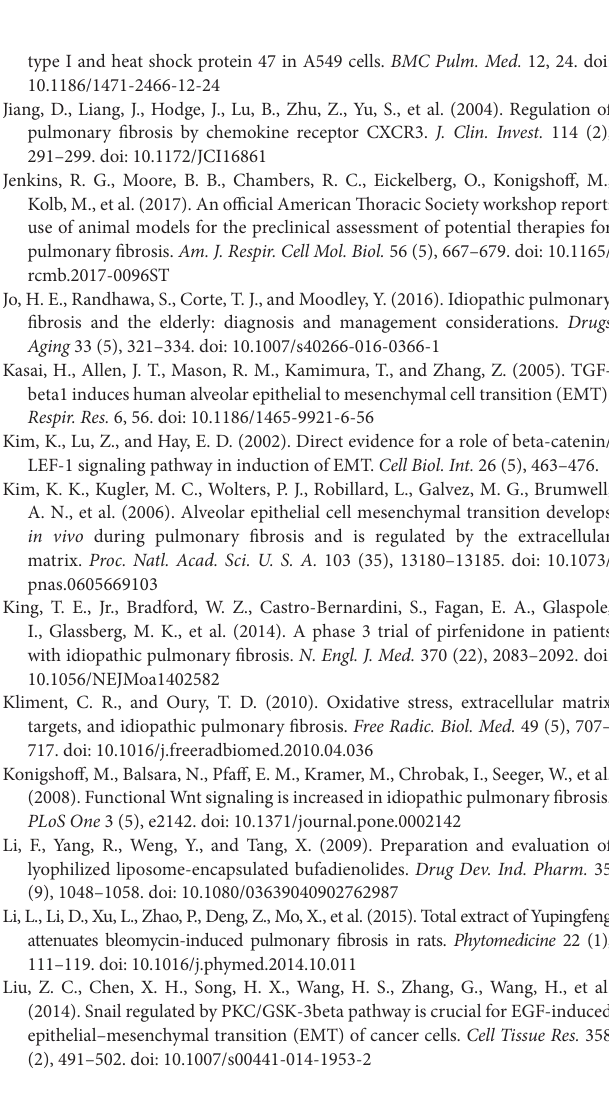
FIGURE S2 | Cinobufagin had no effect on the total levels of TGF- β 1 and TGF- β receptor. (A) Western blot was used to analyze the protein levels of TGF- β 1 in lung tissues. (B) Densitometric analysis of TGF- β 1 in immunoblots using GAPDH as the internal reference. (C) Mlg cells were treated with TGF- β 1 (5 ng·ml −1 ) and cinobufagin (5 and 10 μM) for 24 h (n = 3 per group). The protein levels of TGF- β receptor I (T β RI) and TGF- β receptor II (T β RII) were analyzed by western blot. (D, E) Densitometric analysis of T β RI and T β RII in immunoblots using GAPDH as the internal reference. FIGURE S3 | Cinobufagin inhibits TGF- β 1/Smad3 signaling in alveolar epithelial cells. A549 cells were treated with TGF- β 1 (5 ng·ml −1 ) and cinobufagin (5 and 10 μM) for 1 h (n = 3 per group). The protein levels of (A) Smad3 and P-Smad3, (B) ERK, P-ERK, JNK, P-JNK, P38, and P-P38 were analyzed by western blot. GAPDH was used as a loading control. FIGURE S4 | Cinobufagin inhibits LPS-induced expression of IL-6 and IL-1 β in bone marrow derived macrophages. (A, B) Cultured bone marrow derived macrophages were treated with LPS (1 μg·ml −1 ) and cinobufagin (5 and 10 μM) for 12 h (n = 3 per group). The RNA levels of IL-6 (A) and IL-1 β (B) were analysed by RT-PCR. (C, D) Mlg cells were treated with TGF- β 1 (5 ng·ml −1 ) and cinobufagin (5 and 10 μM) for 12 h (n = 3 per group). The RNA levels of IL-6 (C) and IL-1 β (D) were analysed by RT-PCR. Data are expressed as the means ± SD, *P < 0.05; ***P <